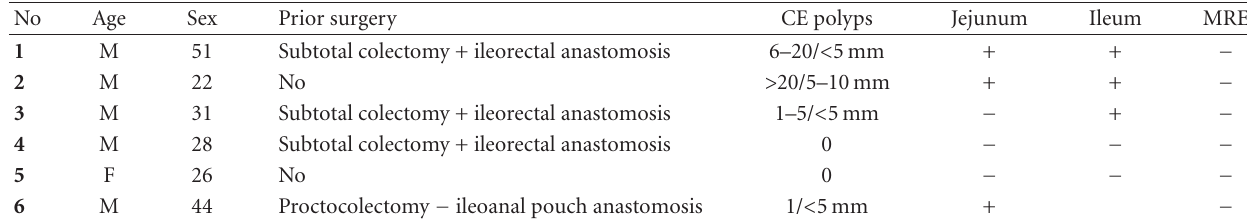
Table 1: Demographic, clinical, CE, and MRE findings of the